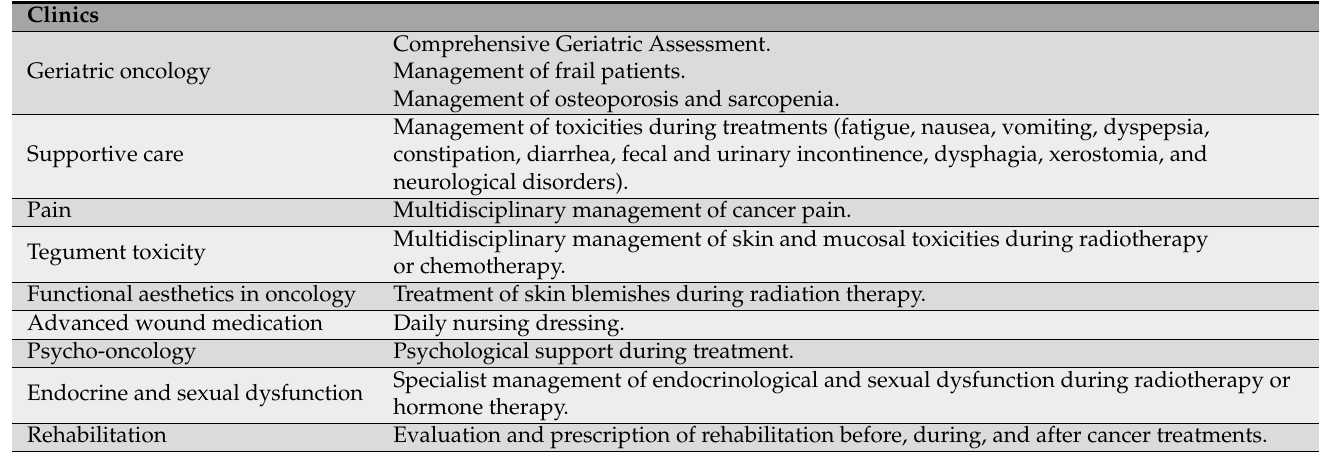
Table 1. Outpatient services performed by the multidisciplinary